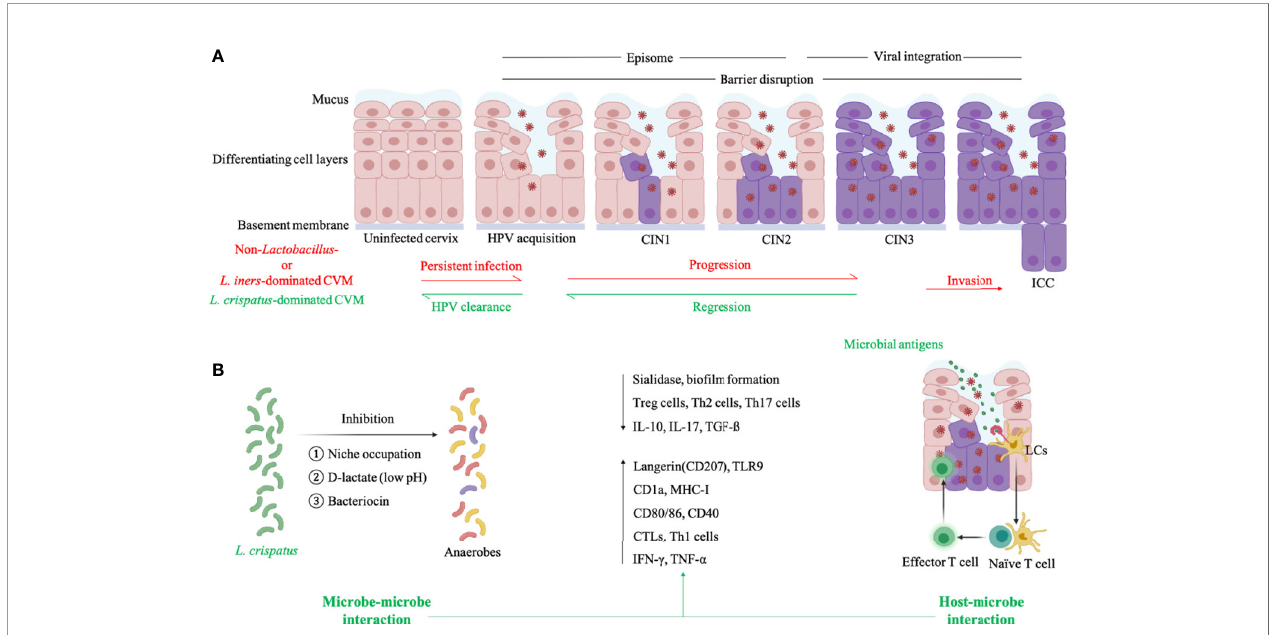
FIGURE 2 | Cervicovaginal microenvironment in persistent HPV infection and natural HPV clearance. (A) L. iners - or non- Lactobacillus -dominated CVM is characterized by allowing the proliferation of anaerobes which produce sialidase to disrupt epithelial barrier and then facilitate the entry of HPV. HPV particles exist in infected keratinocytes as episomes before entry into the nucleus, and viral integration induces high expression of E6/E7 proteins to promote abnormal cell proliferation as well as carcinogenesis. L. crispatus -dominated CVM is associated with natural HPV clearance and CIN regression. (B) For HPV-positive women with L. crispatus -dominated CVM, L. crispatus can inhibit growth of anaerobes through several mechanisms (microbe-microbe interaction) and activate LCs which is the only APCs in cervical epithelium to present HPV antigens and induce HPV-speci fi c CMI (host-microbe interaction). Both microbe- and host-microbe interaction decrease the level of factors correlated with barrier impairment (sialidase and bio fi lm of anaerobes) and suppressive immunity (Treg, Th2, Th17 cells, IL-10, IL-17, TGF-ß), and increase the expression of biomarkers in activated LCs (antigen-binding langerin and TLR9, antigen-presenting CD1a and MHC-I, co-stimulatory molecule CD80/86 and CD40) as well as CMI-associated molecules (cytotoxic T lymphocytes-CTLs, Th1 cells, IFN- g , TNF- a ). This fi gure applied icons in